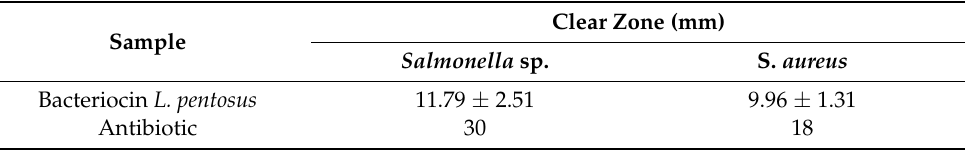
Table 3. Antimicrobial activity of purified